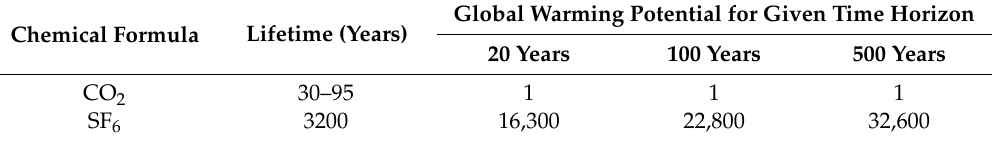
Table 1. Atmospheric lifetime and GWP at different time horizon for SF 6 and CO 2 [1].